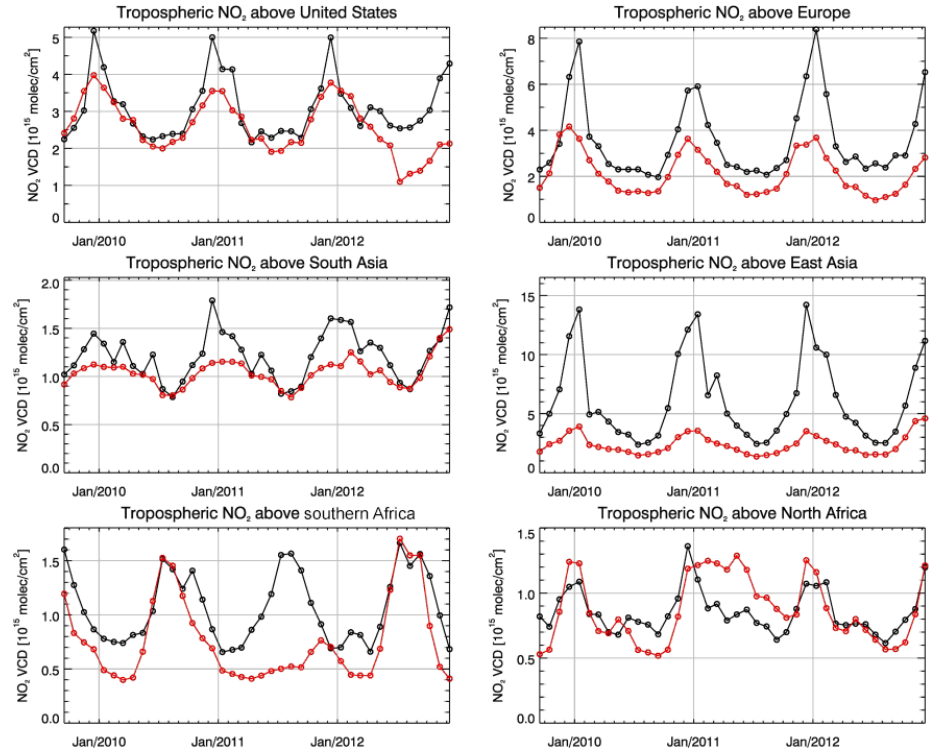
Figure 17. As in Fig. 16 but for monthly means of daily tropospheric NO 2 VCD [10 15 moleccm − 2 ] averaged over different regions. Top: United States (left), Europe (right); second row: South Asia (left), East Asia (right); bottom: southern Africa (left), North Africa